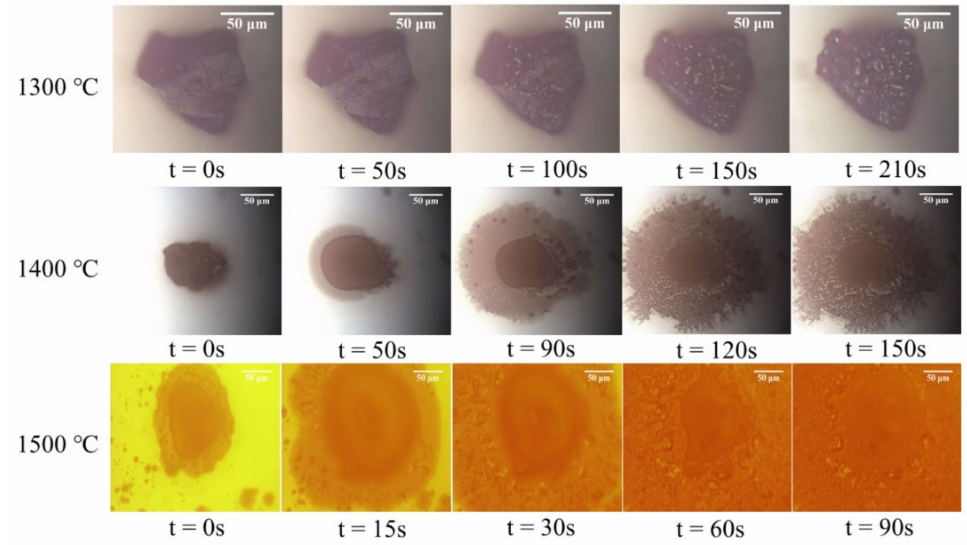
Figure 4. Images of reduction processes of single magnetite particle in the CO atmosphere at different